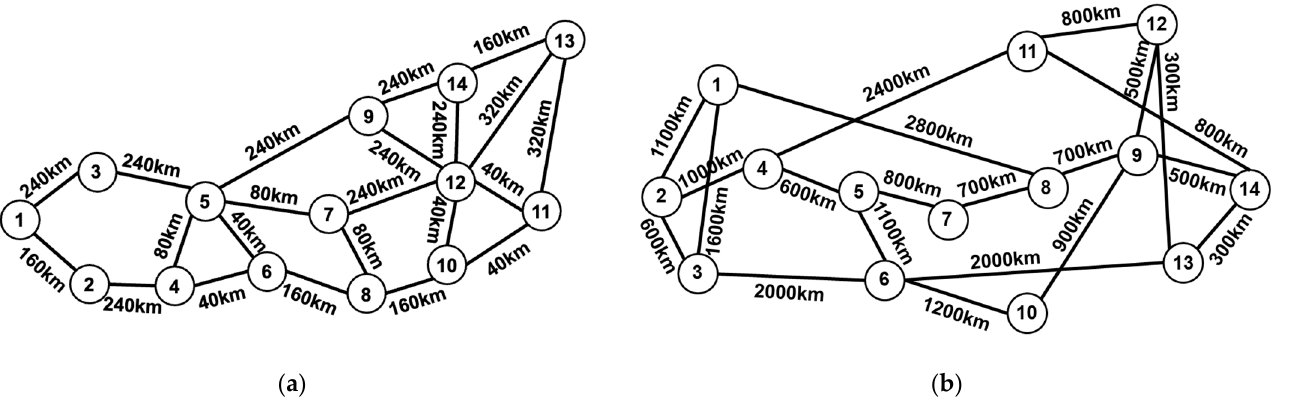
Figure 2. ( a ) Japan network (Jnet) topology; ( b ) National Science Foundation network (NSFnet) topology.